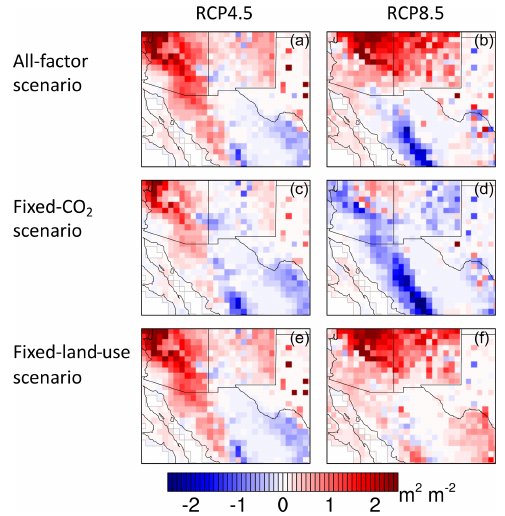
Figure 1. Simulated changes in spring averaged monthly mean veg- etation area index (VAI) in southwestern North America under the three conditions for RCP4.5 and RCP8.5. Changes are between the present day and 2100, with 5 years representing each time period. The all-factor case (a, b) includes the effects of climate, CO 2 fer- tilization, and anthropogenic land use on vegetation; only climate and land use are considered in the fixed-CO 2 case (c, d) ; and only climate and CO 2 fertilization are considered in the fixed-land-use case (e, f) . Results are from